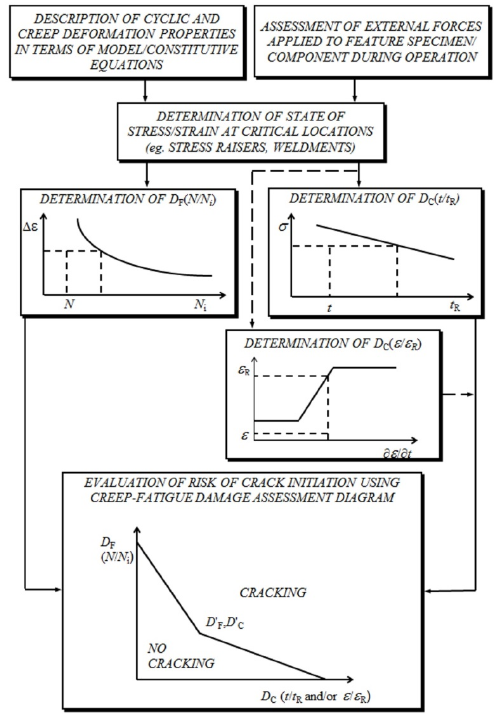
Figure 6. Generic flow diagram representing creep ‐ fatigue crack initiation assessment procedure.